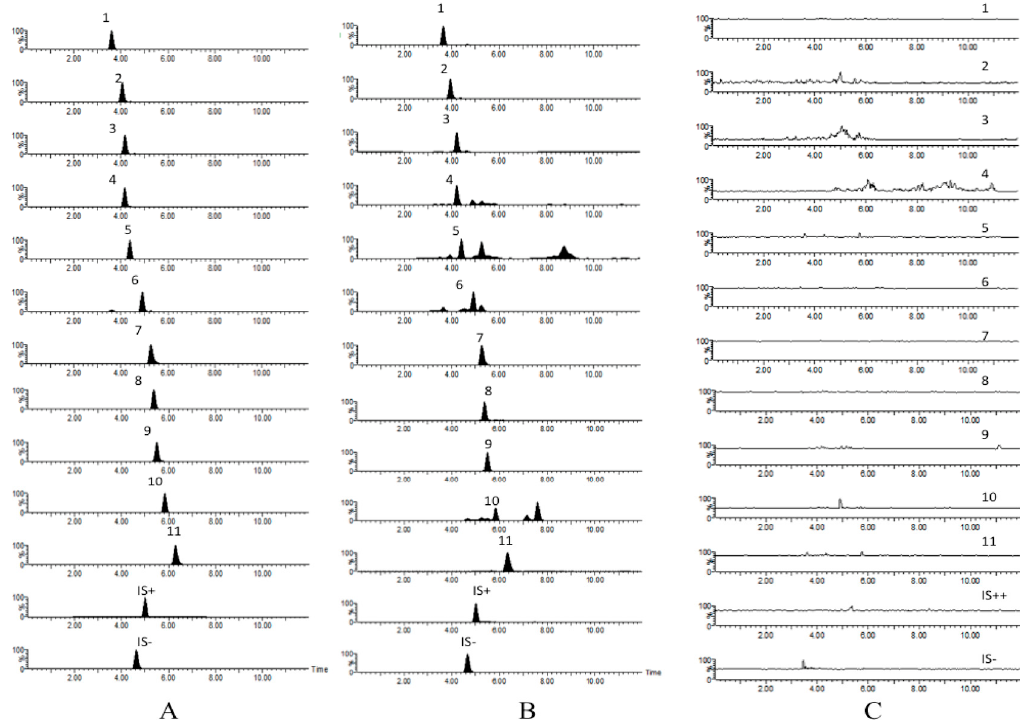
Figure 2. Active extraction MRM chromatograms of compounds 1 – 11 , chloromycetin (IS − ) and diphenhydramine (IS+): ( A ) blank plasma spiked with the 11 analytes and IS; ( B ) 15 min sample of plasma after a single oral dose of HYD; ( C ) blank plasma.